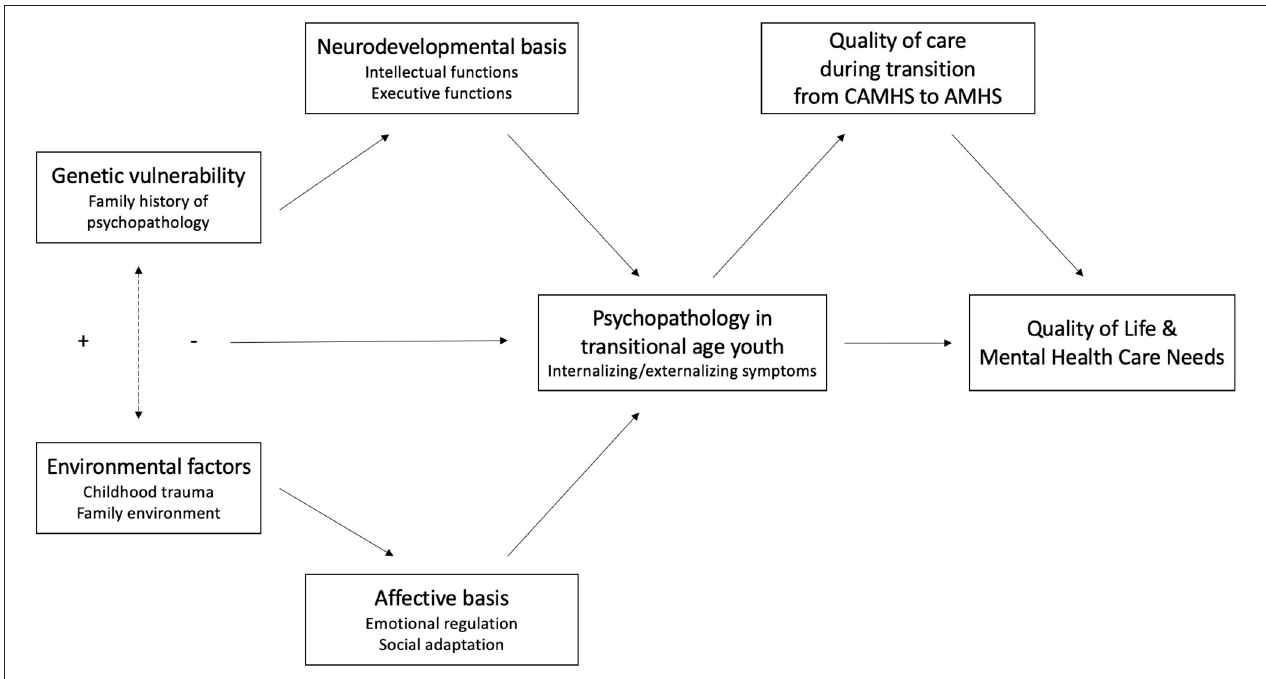
FIGURE 2 | Conceptual model of the primary